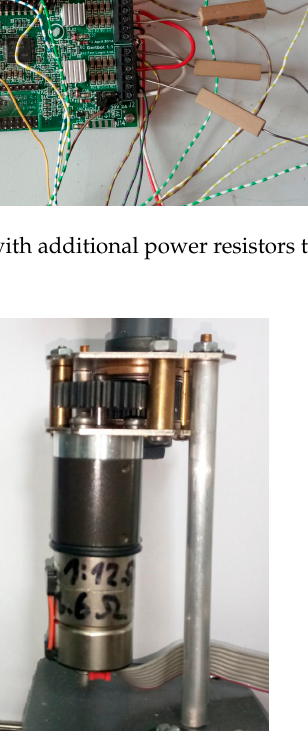
Figure 12. Stepper motor with reduction gear.